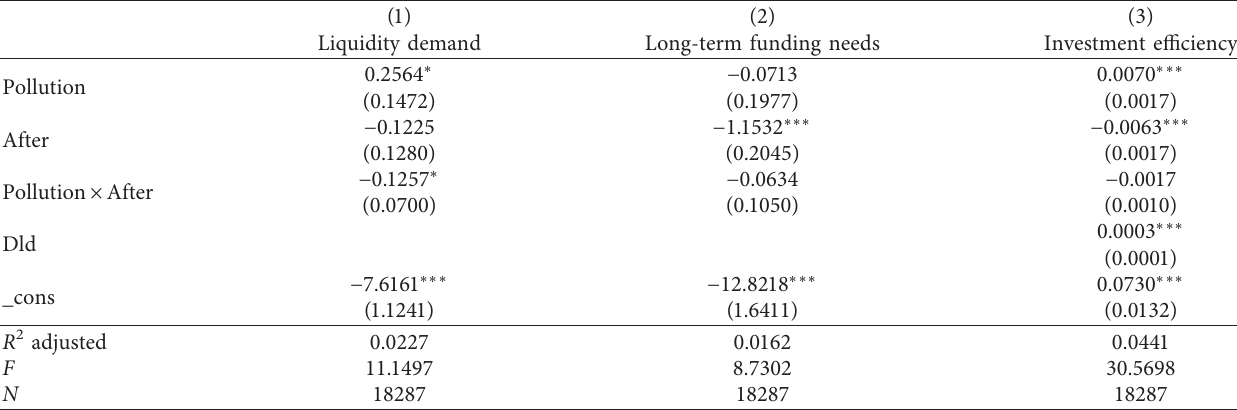
Table 8: Mechanism of green credit affecting investment efficiency.